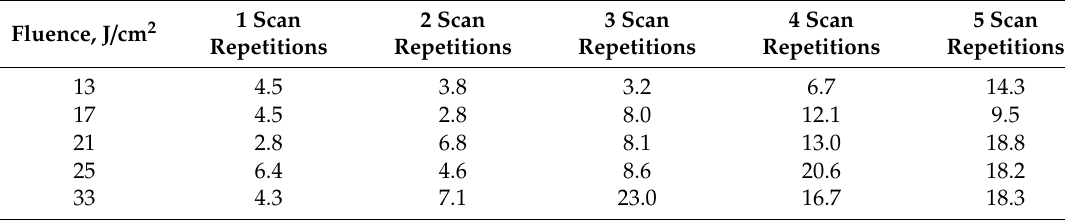
Table 4. R z roughness parameter for laser-treated areas, µ